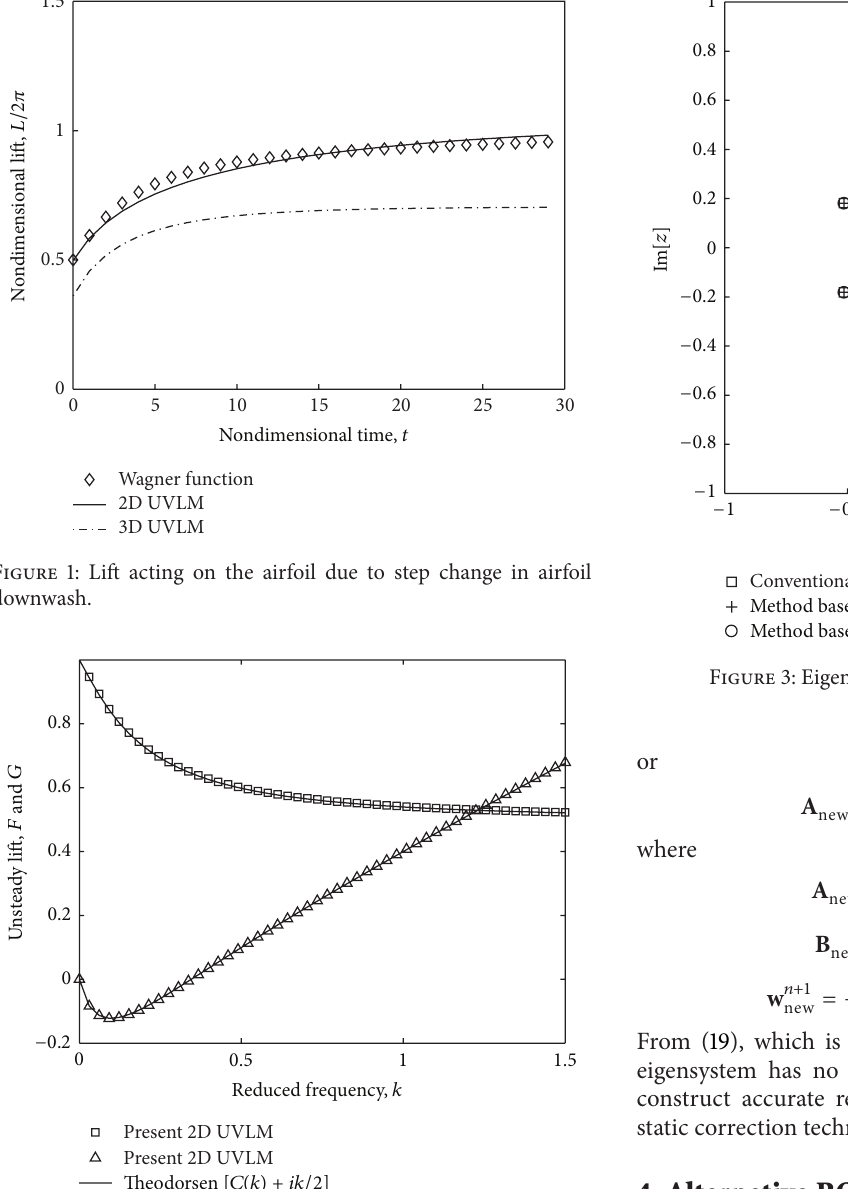
Figure 2: Unsteady lift due to plunging motion of an isolated airfoil.